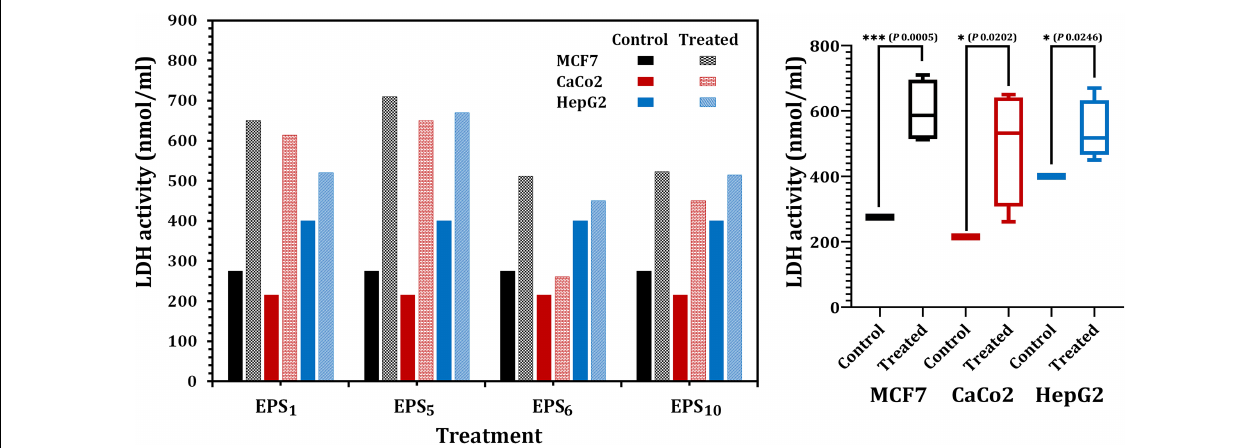
Figure 5 | Lactate dehydrogenase (LDH) activity in MCF7, CaCo2, and HepG2 treated with different EPSs. EPS 1 , EPS derived from S. thermophilus DSM 24731; EPS